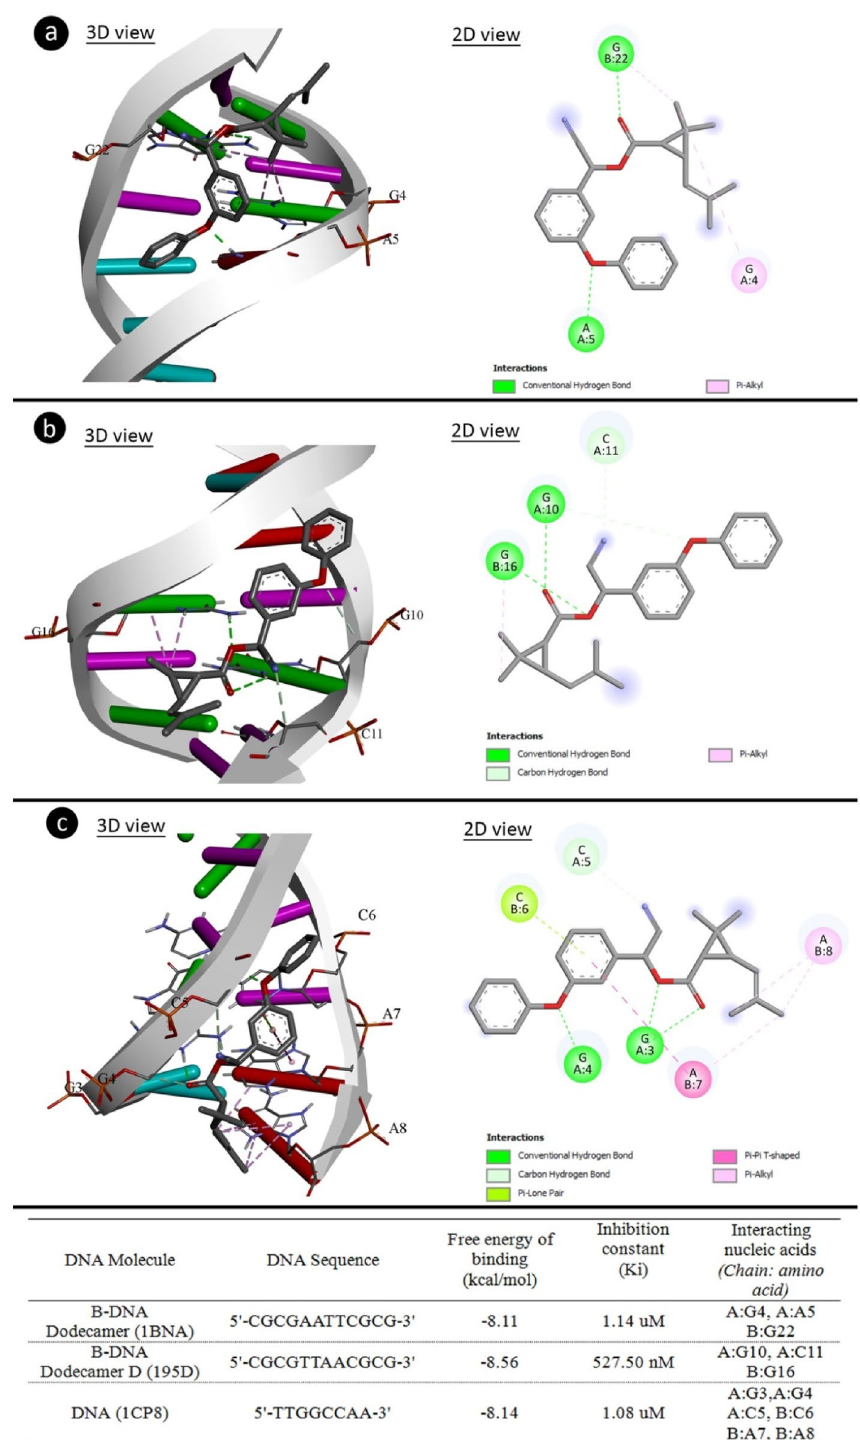
Figure 7. The molecular interactions of cypermethrin with DNA molecules. 1BNA ( a ), 195D ( b ), 1CP8 ( c